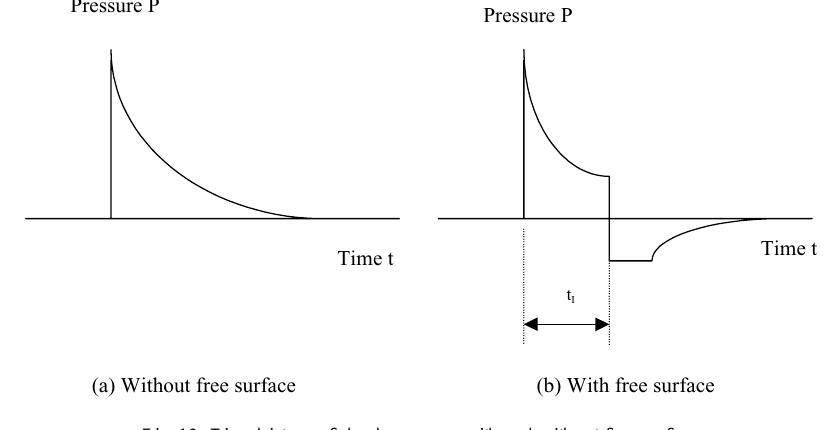
Fig. 10. Time history of shock pressure with and without free surface.